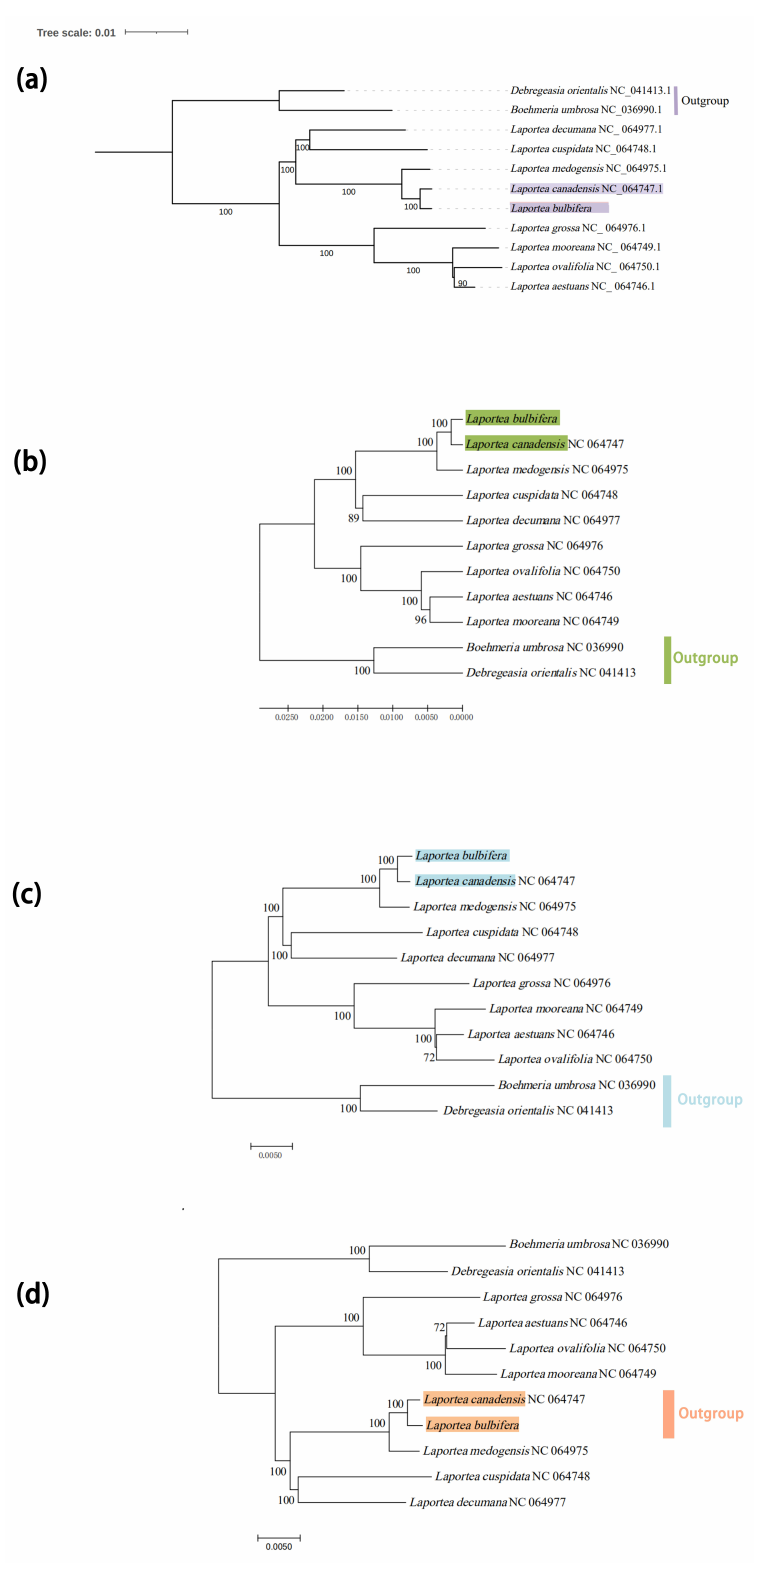
Figure 7. The phylogenetic tree of species from Laportea is based on 78 CDSs. ( a ) Phylogenetic tree constructed using the maximum likelihood (ML) methods. ( b ) Phylogenetic tree constructed using the unweighted pair group method with arithmetic mean (UPGMA) methods. ( c ) Phylogenetic tree constructed using the minimum evolution (ME) methods. ( d ) Phylogenetic tree constructed using the neighbor-joining (NJ)